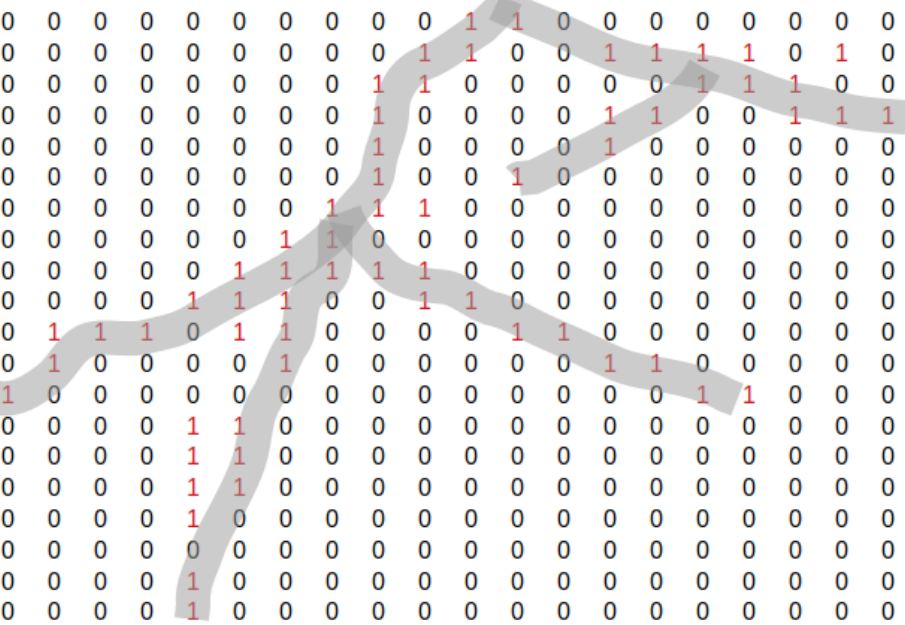
Figure 3. An illustrative example of semantic label map on a patch of a root image. The patch example is seen as a matrix, where indices with the value of 0 correspond to the background class and those with the red value of 1 correspond to the root class. Since the width of roots’ annotations is between 1 and 3 pixels, we highlight the red indices here in light gray so the form of the root is clearly